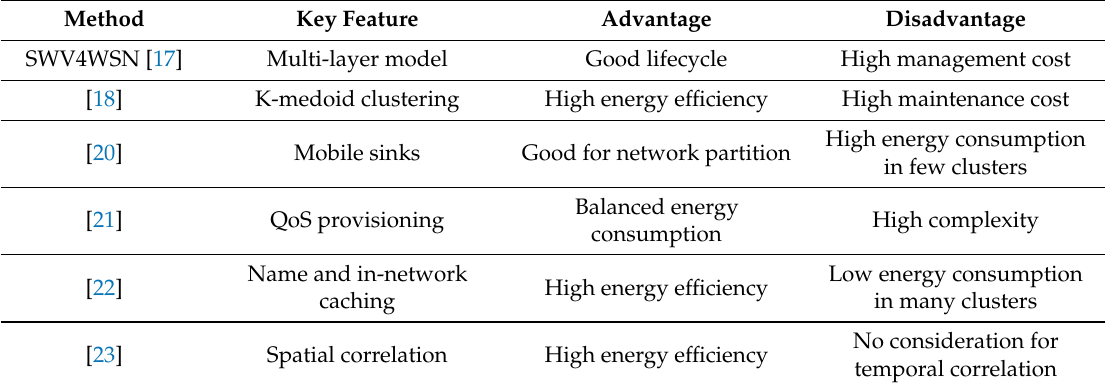
Table 1. Comparison of advantages and disadvantages for